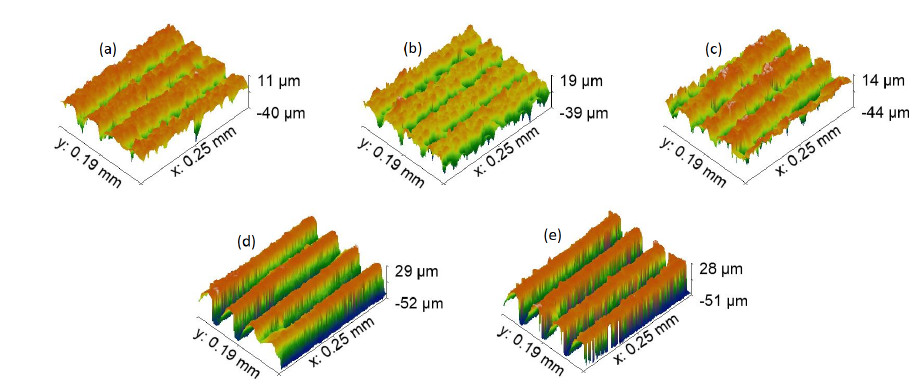
Figure 8. Topography, with × 50 magnification of each sample grooves texture. ( a )—17-4PH stainless steel, ( b )—PH13 stainless steel, ( c )—Ti6Al4V titanium, ( d )—2024 T3 aluminum, and ( e )— 7050 aluminum.